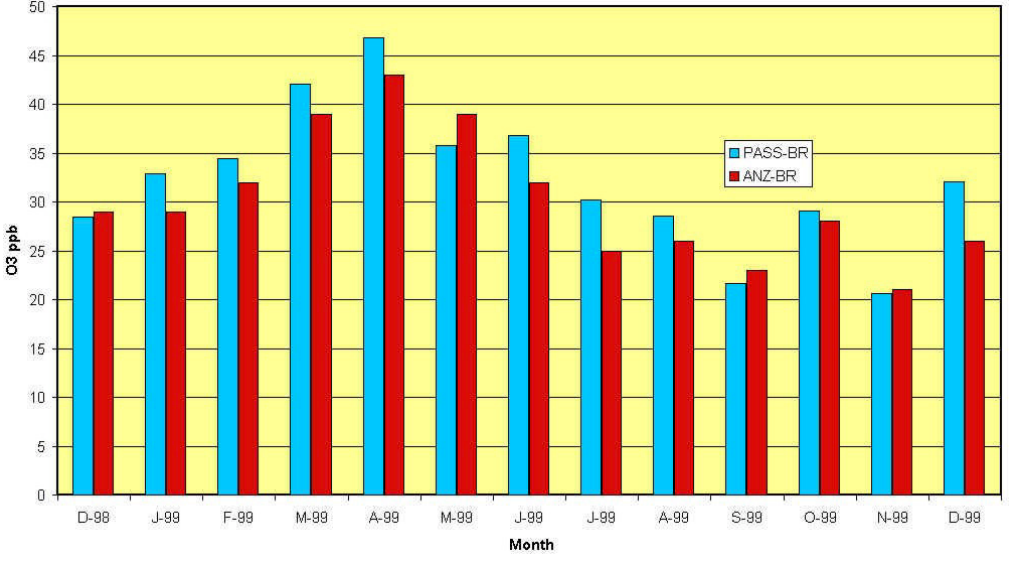
FIGURE 6. Validation results of PASS NO 2 by AEP in Edmonton and Calgary Canada from December 1998 to December 1999 (courtesy from